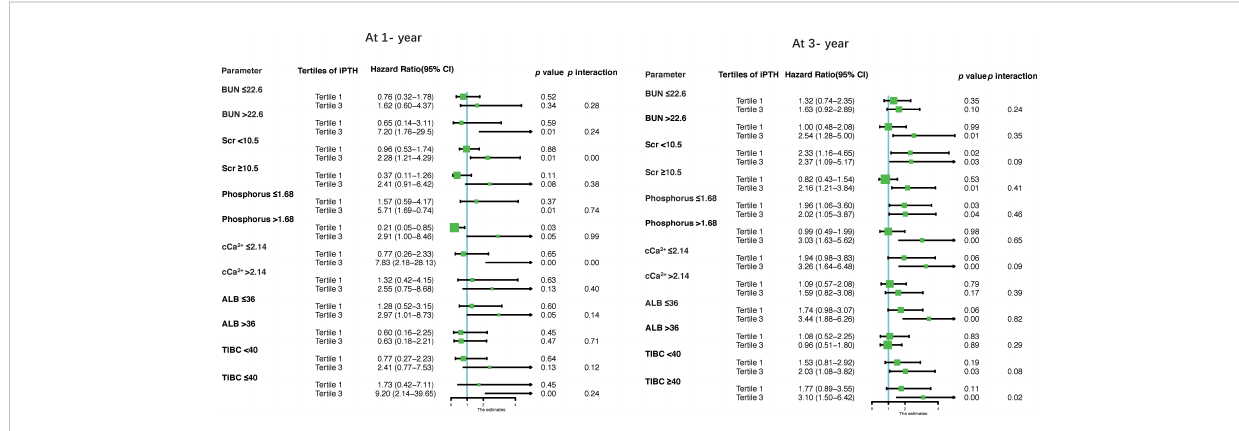
FIGURE 4 Forest plots for strati fi ed analyses. BUN , blood urea nitrogen; Scr , serum creatinine; cCa 2+ , corrected calcium; ALB , albumin; TIBC , total iron binding